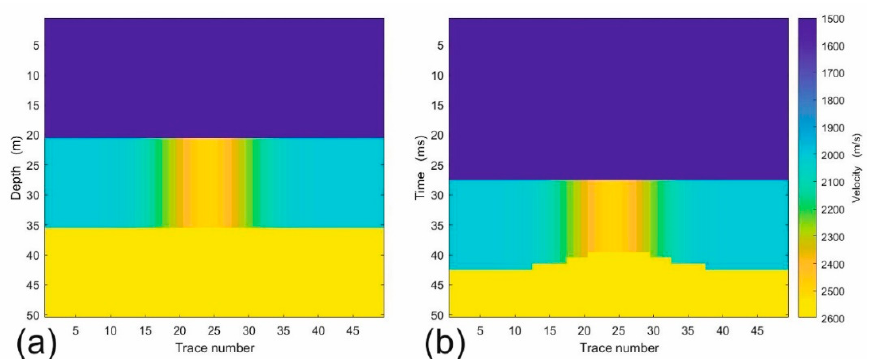
Figure 3. Synthetic model with horizontal interfaces and a Gaussian velocity anomaly in the depth domain ( a ) and in the time domain ( b ).